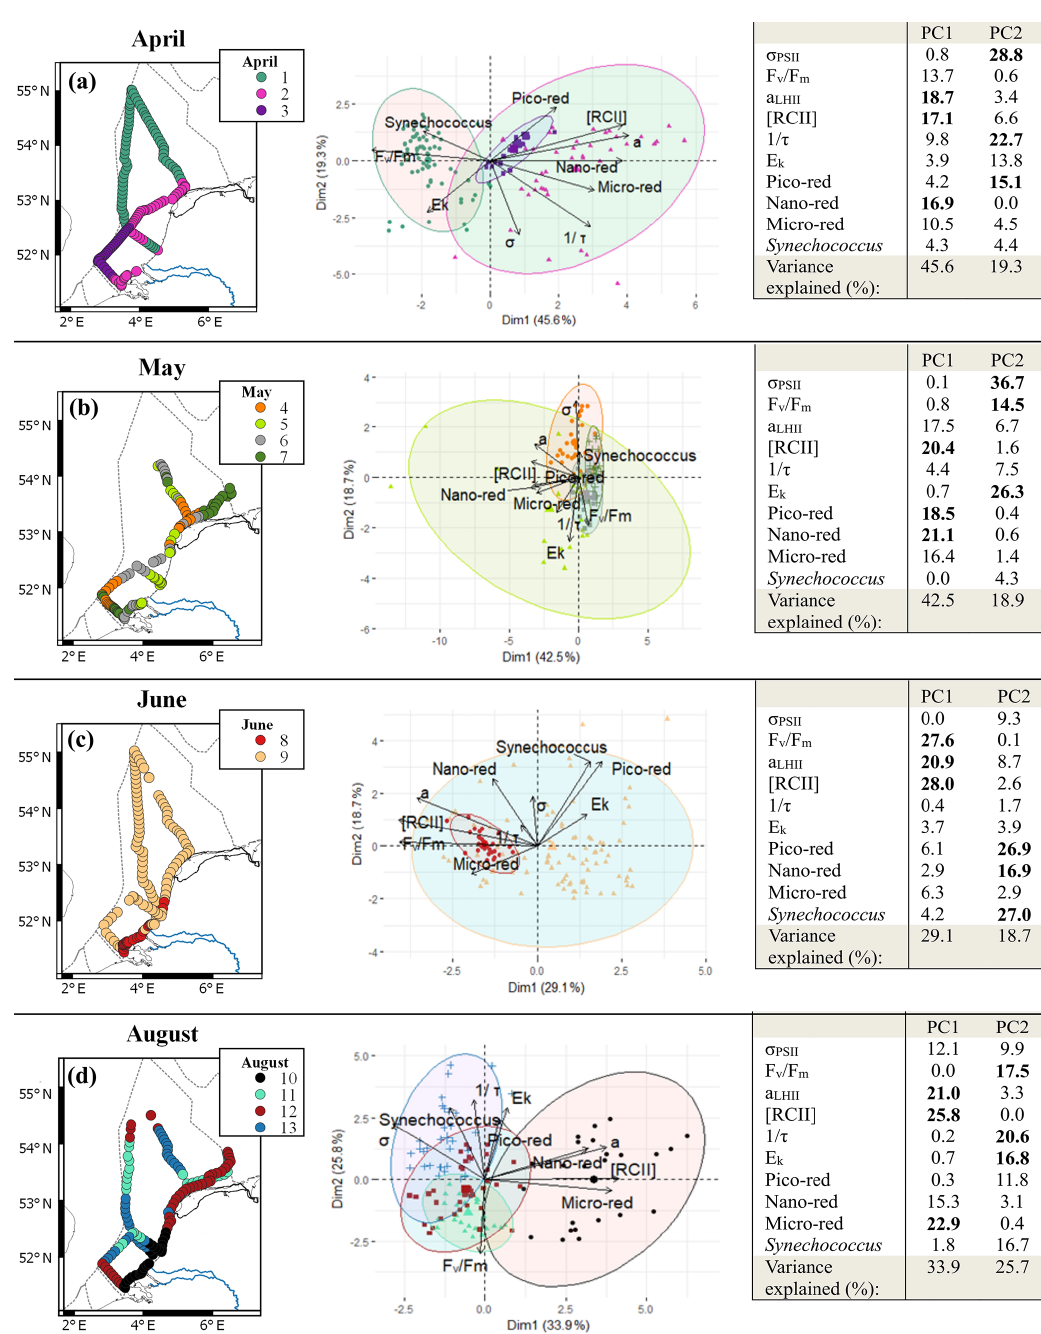
Figure 7. Overview of the spectral cluster analysis based on the non-collinear phytoplankton parameters (FCM: pico-red, nano-red, micro- red, Synechococcus ; FRRf: σ PSII , F v /F m , a LHII , 1 /τ , E k ) separated per month ( a to d : April, May, June, and August). On the left the clusters are visualized on maps and in the middle are the bi-plots of the PCA of the data with confidence ellipses per cluster (confidence 95%). In all graphics clusters are visualized by different colors as shown in the legend inset. For the confidence ellipses the border lines (and not the fill) correspond to the clusters. In the bi-plot overlapping confidence ellipses suggest a high similarity between groups, while the size of the ellipse is a measure of variability within the group. On the right is the PCA table with contributions in percent of the different variables; in bold are the three variables that contribute most to the principal component. Maps were made with QGIS v2.14.2 using EEZ zone data from the Flanders Marine Institute (2018). The PCA visualization was done in R using the supplemental R package factoextra (Kassambra and Mundt,